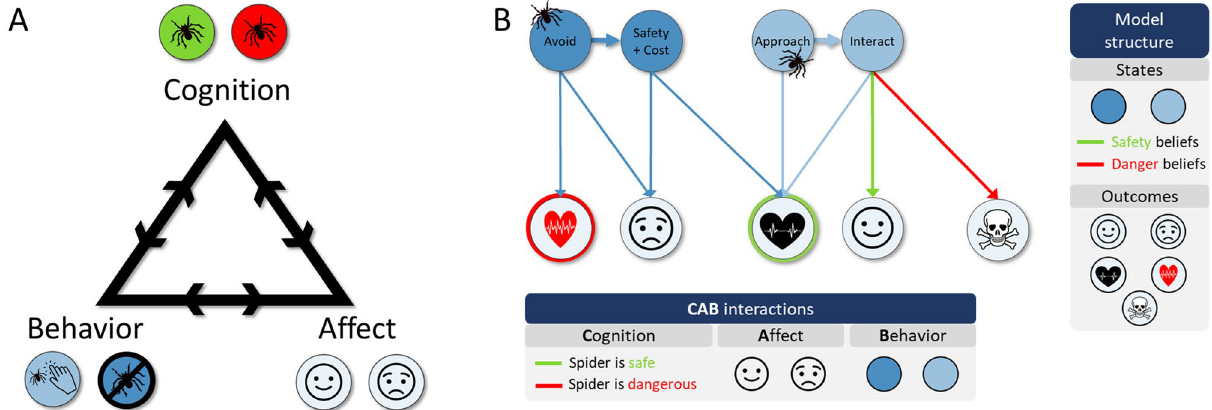
Figure 1. Illustration of how the structure of the computational model described in this paper captures the cognition-affect-behavior triangle, using the example of spider phobia. ( A ) Cognition-affect-behavior triangle, as used in CBT. Each component has reciprocal links to the other two components. For example, a thought can promote congruent emotions and behaviors, and an emotion can also promote congruent thoughts and behaviors. In this case, the thought “the spider is dangerous” may promote “negative affect’ and “running away” (circles on the right-hand side of each apex). ( B ) Simplified depiction of the computational model structure, designed to capture the outcomes an individual expects if they choose approach or avoidance behavior after seeing a feared stimulus (a spider in this example), depending on their thoughts (here, beliefs that a spider is dangerous or safe). Cognition and behavior within the CBT triangle form the model states. Affect and arousal are outcomes, which depend on cognitions and chosen behaviors, as well as their interactions. This figure includes icons created by the Noun Project (https:// theno unpro ject.